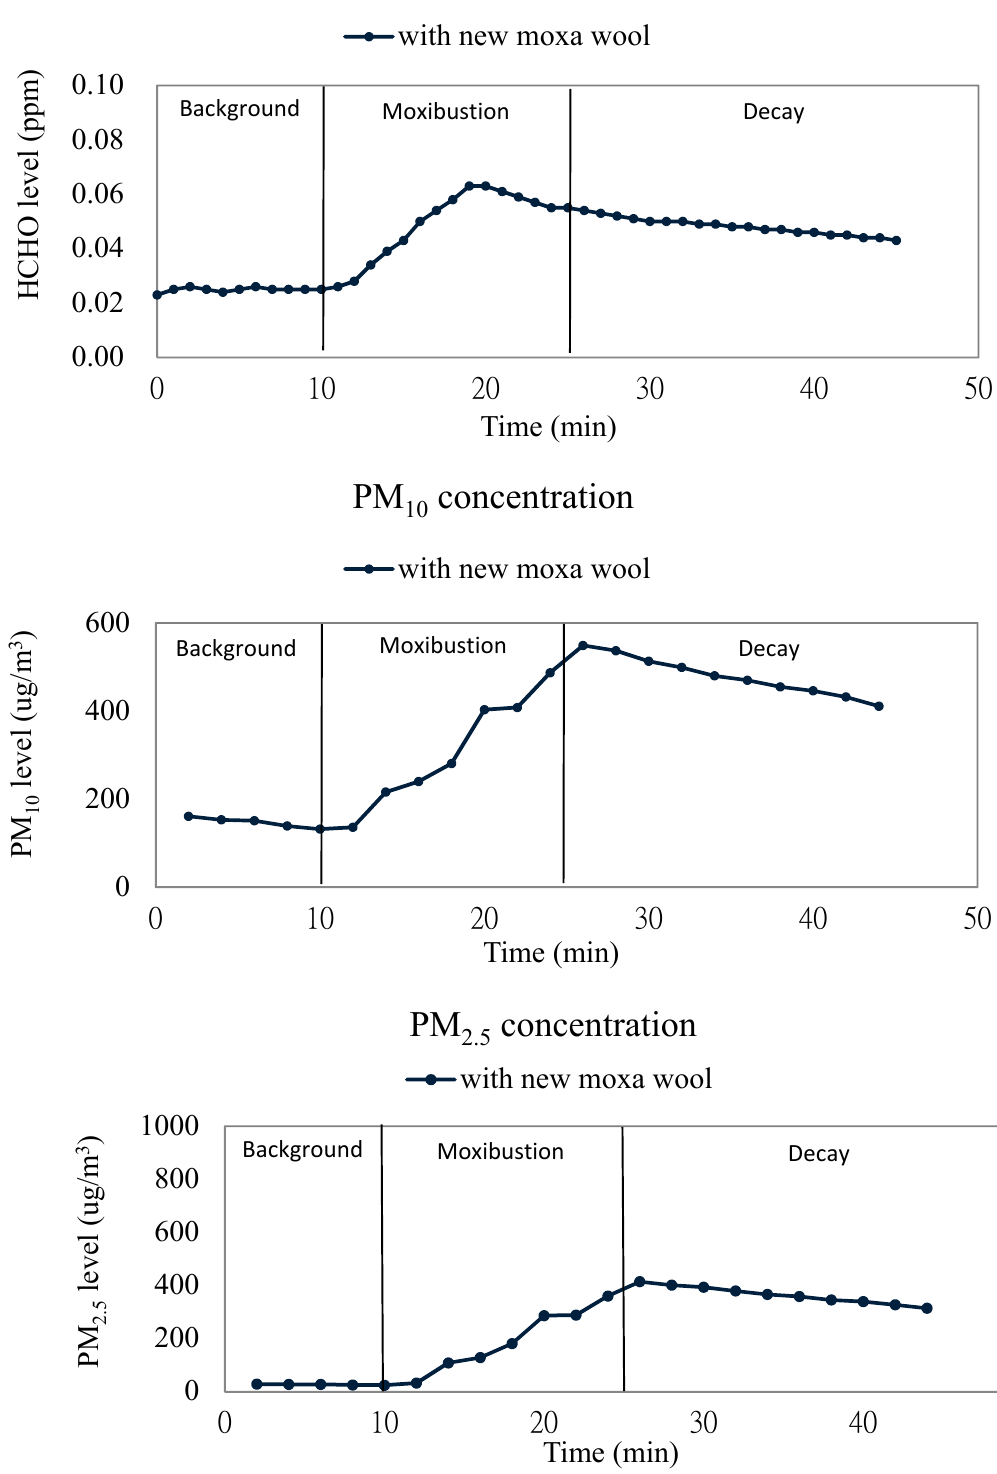
Figure 3. Continuous measurements of Indoor air pollutants from moxibustion emission of a new moxa inside the acupuncture and moxibustion room.